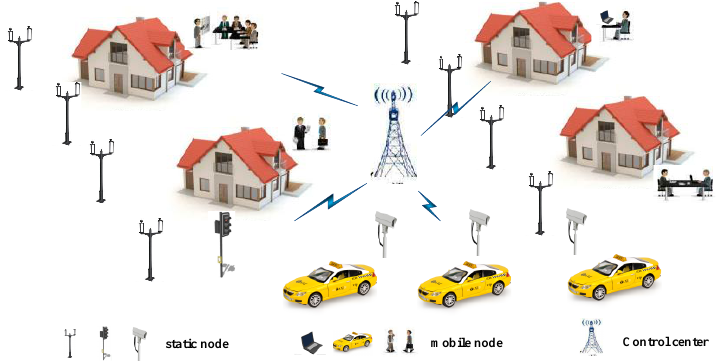
Figure 1. System model of high-density Internet of Things (IoT) .